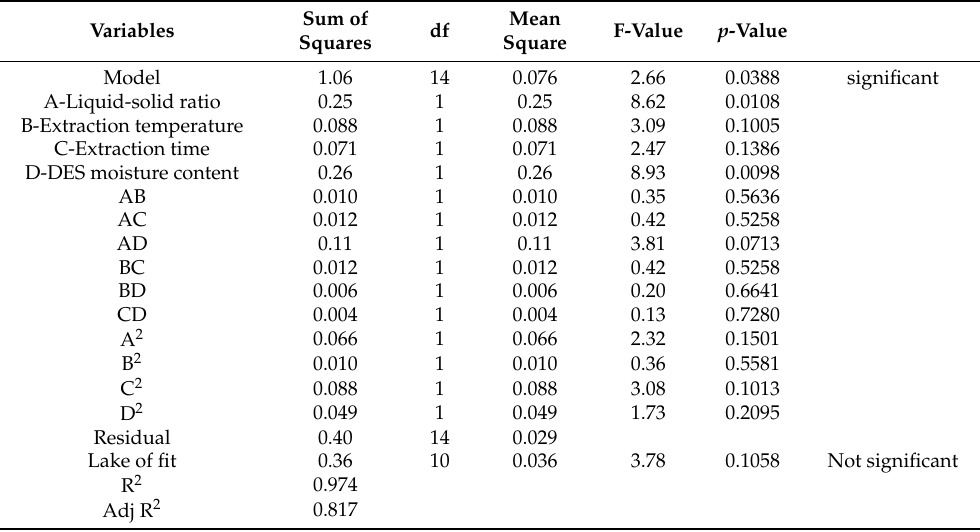
Table 5. The analysis of variance (ANOVA) results of the quadratic multiple regression model for total coumarin